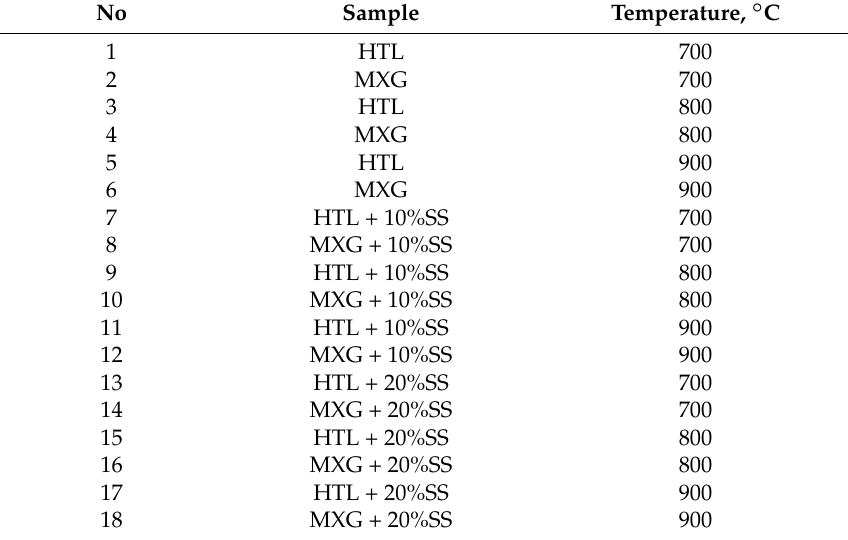
Table 2. Objects of the Hierarchical Clustering Analysis—fuel samples gasified at various temperatures. No Sample Temperature, ◦